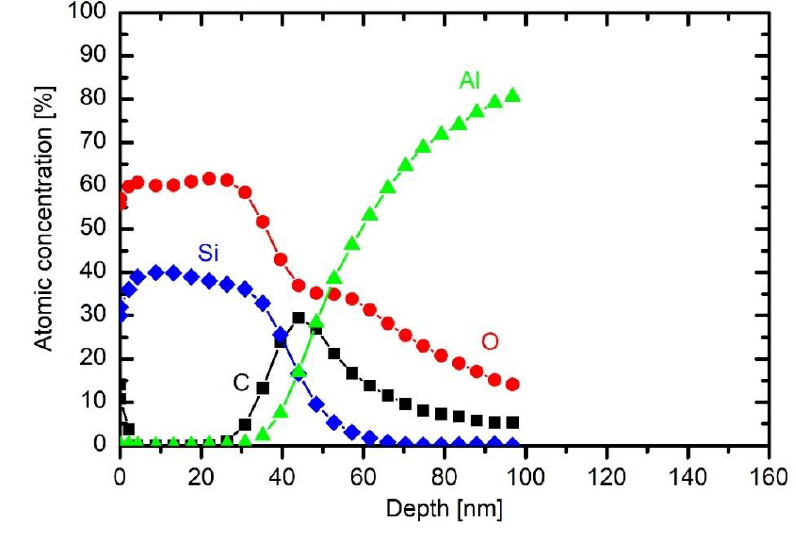
Figure 10. XPS depth profile of a sample exposed to plasma of 10 Pa HMDSO and 20 Pa O 2 for 30 s at 200 W.